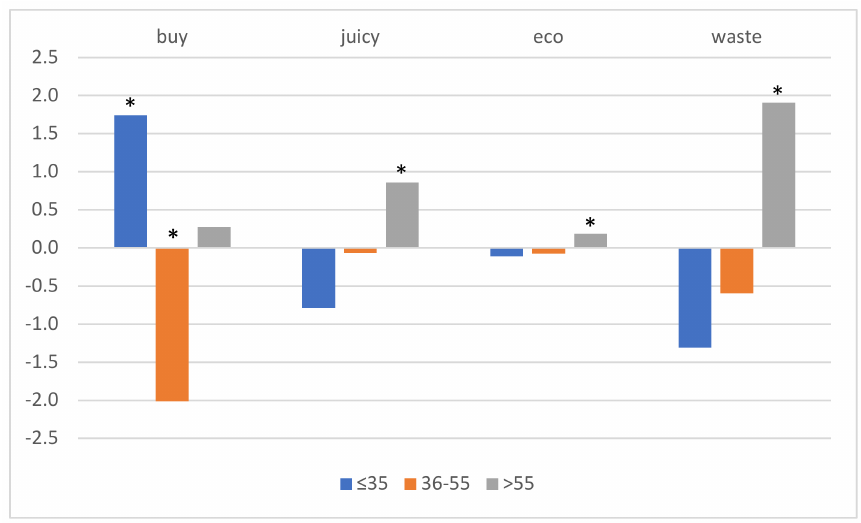
Figure 2. Expected minus counted percentages for variables and criteria affected by consumer age. * Groups in which differences were significant are marked with an asterisk; -buy-, “Are you the person in charge of beef-buying at home?”; -juicy- and –eco-, based on the color of the five steaks; -waste-, chosen